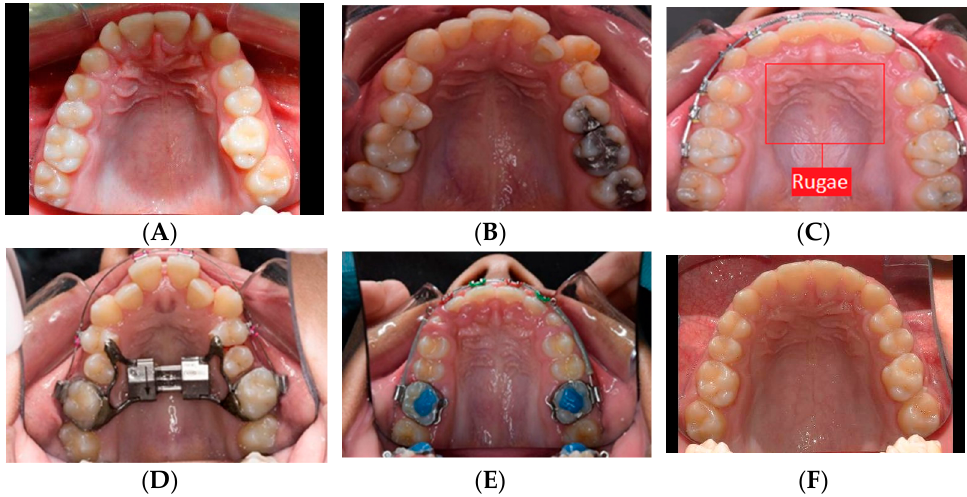
Figure 1. Samples of the maxillary arch images showing the variety of malocclusions, including pretreatment ( A , B ), during treatment ( C – E ), and post-treatment ( F ) images. To retain the aspect ratio of the original images, a black border was added to avoid side stretching to match the 480 × 320 size ( A , F ). The background change in the image did not affect the results. A sample of the selected rugae area is shown in ( C ).